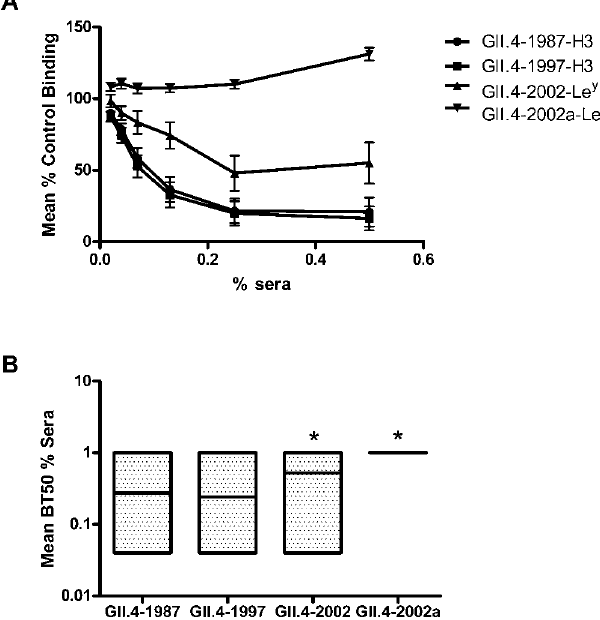
Figure 9. Blockade of GII.4 VLPs Binding to HBGA by Outbreak Sera Convalescent serum samples collected from a GII.4 outbreak in 1988 were assayed for blockade of GII.4–1987 and GII.4–1997-H type 3, GII.4– 2002-Le y , and GII.4–2002a-Le a interaction and the mean percentage of control binding calculated compared to the no-serum control binding (A). Error bars represent SEM. The floating bar plot (B) shows the mean percentage of sera needed for BT50 for each VLP. The mean titer is indicated by the line in the box. The upper and lower boundaries of the box represent the maximum and minimum values. *Outbreak sera BT50 responses significantly different from GII.4–1987 ( p , 0.05, M-W) (Figure 12). Our inability to identify carbohydrates that efficiently bound GII.4–2004 and GII.4–2005 precluded the testing of sera from historic strains to block the binding of contemporary strains to HBGAs. None of the antisera generated to the GII.4 panel blocked NV-H type 3 inter- actions at any of the serum concentrations tested (unpub- lished data). These data support the hypothesis that not only does antigenic drift occur in the capsid region of GII.4